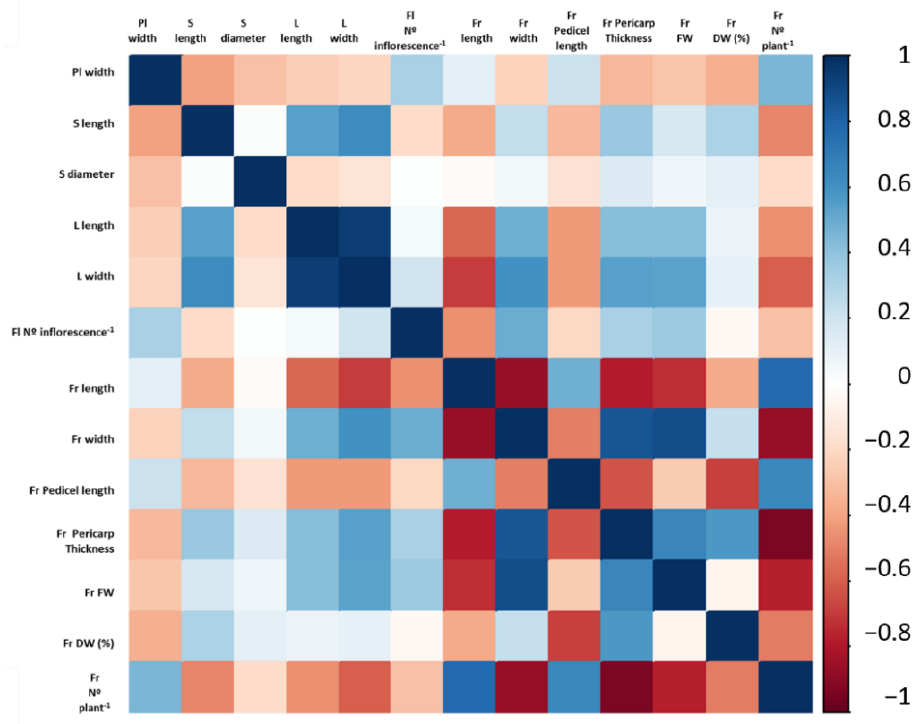
Figure 9. Correlation network discerning the relation among 13 quantitative traits. Correlations between traits are illustrated using different gradient colors of blue and red to discern positive and negative correlations, respectively. The color intensity of the lines connecting traits explains the correlation robustness while Pl: plant, S: stem, L: leaf, Fl: flower, Fr: fruit, FW: fresh weight, DW: dry weight.